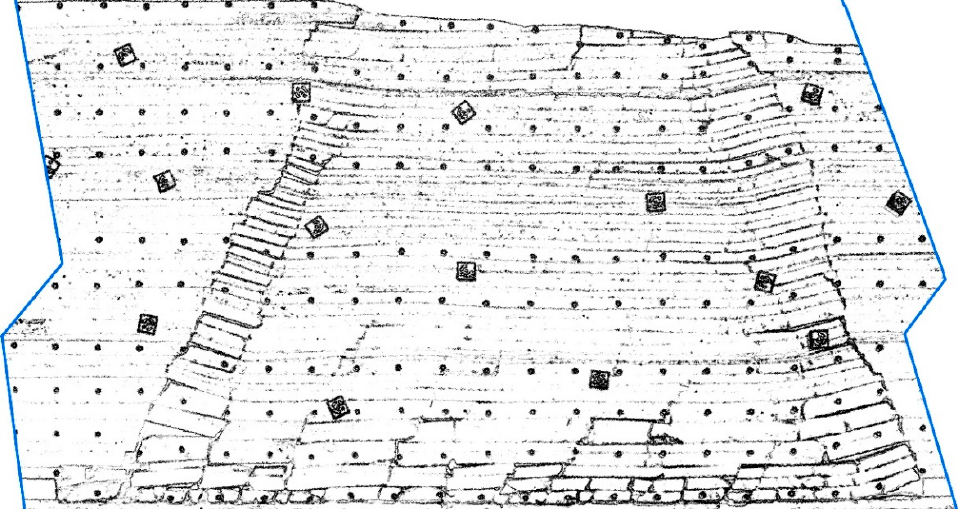
Figure 9. Sketch drawing of overburden failure at 300 m.